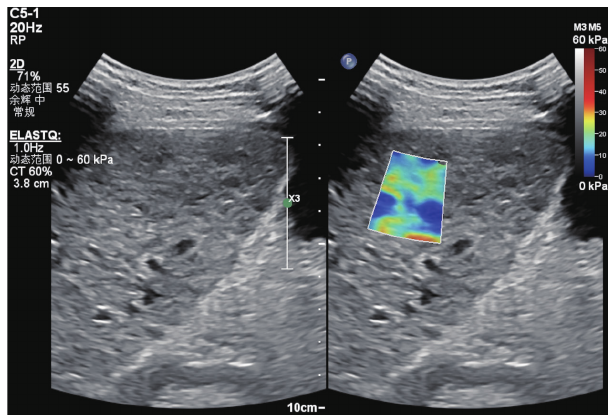
Figure 1 TE images in a 33-year-old man with a history of hepatitis B. Transient elastography of the liver performs with the Philips EPIQ 7 system through intercostal access. The measurement is given in kPa. The hardness of the liver is 15.2kPa, which is above the normal